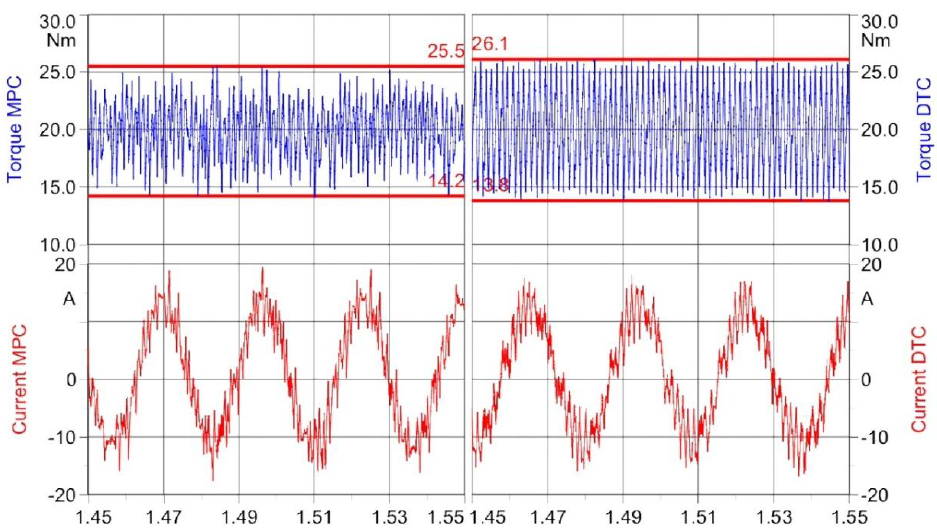
Figure 10. Comparison of the ripples in torque waveforms in DTC (right) and PTC (left). The torque ripple is lower in case of the PTC run by 1 Nm.